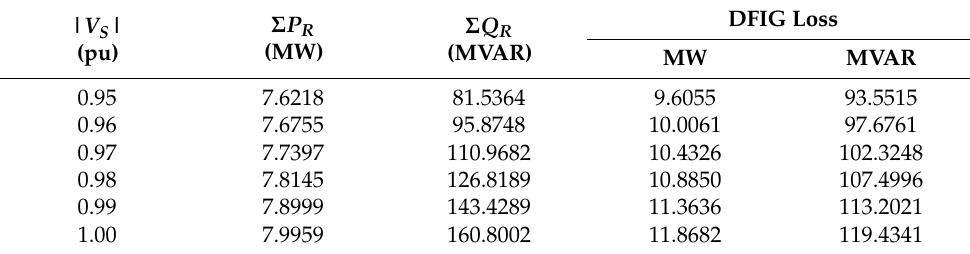
Table 7. Rotor power and DFIG power loss ( V w = 8